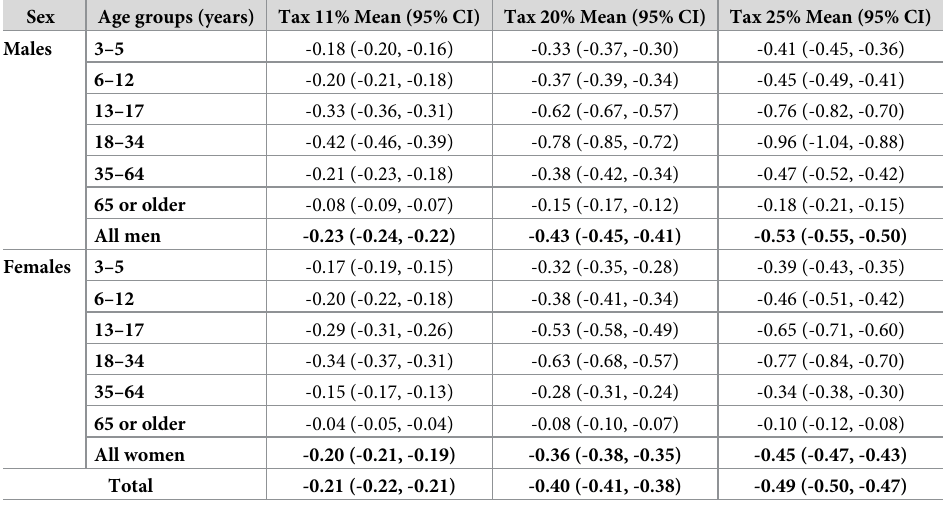
Table 4. Estimated change in BMI (kg/m2) after a 11%, 20% and 25% SSB tax by sex and age groups.